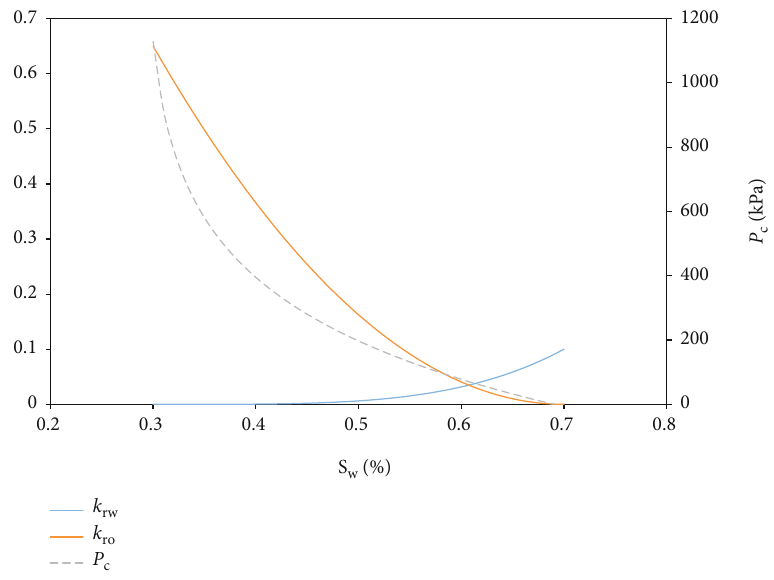
Figure 5: Relative permeability and capillary pressure curves.